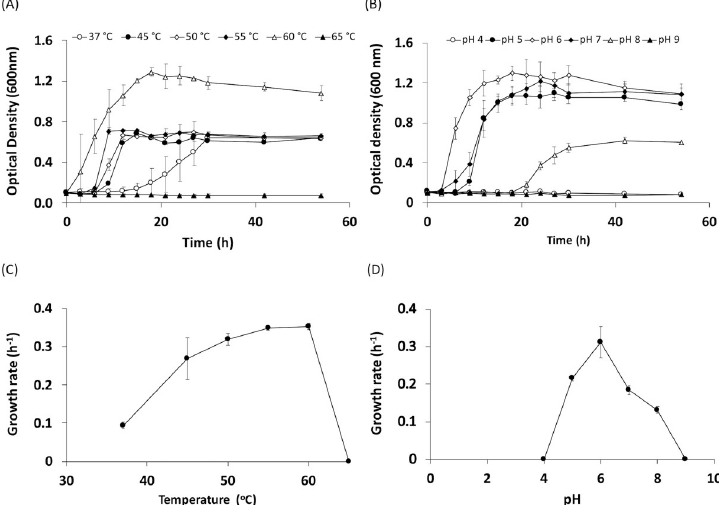
Fig 3. Growth characteristic of Thermoanaerobacterium sp. R63. Thermoanaerobacterium sp. R63 was grown in T6 medium supplemented with 1% glucose. Growth of the bacteria was followed up to 54 h, with an interval of 2 h during the first 20 h under different temperature (A), and pH (B). Growth rate of the bacteria was calculated from slope of natural log of OD 600 at the linearity versus time under different temperature (C), and pH (D). Data were evaluated from three and four independent experiments for temperature and pH, respectively. Error bars in graphs represent standard deviation of the